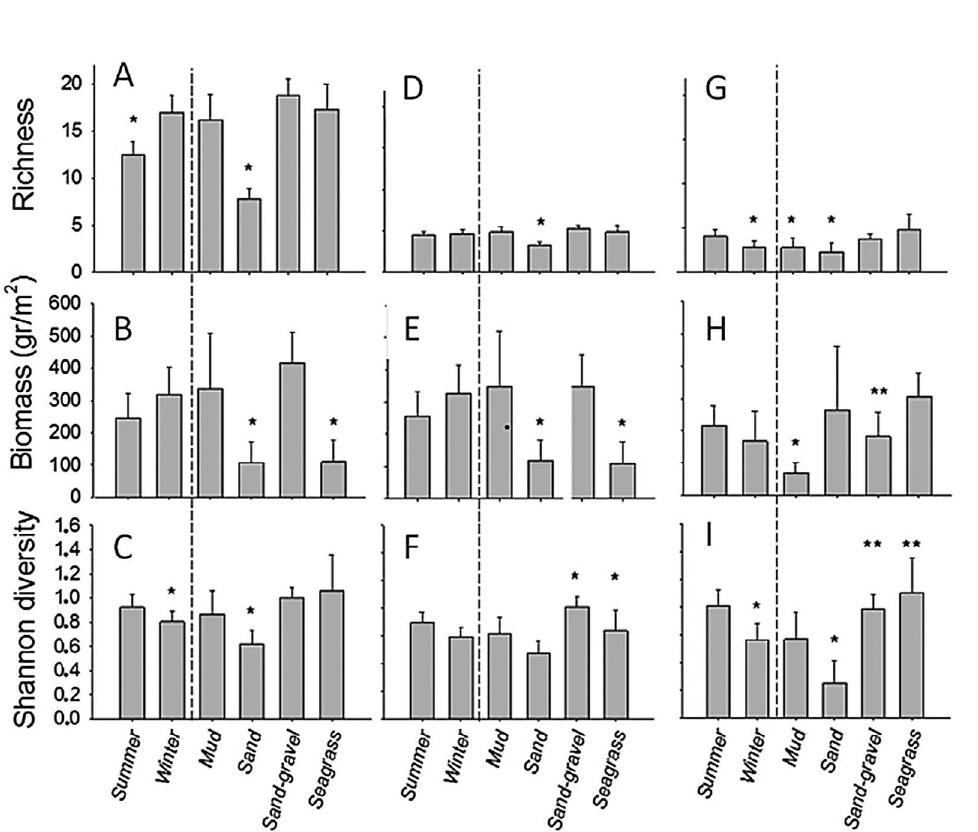
Fig. 2. – Invertebrate community richness, biomass and Shannon diversity (H’) variability across seasons and habitats in Tongoy Bay. (A, B, C), index estimations calculated for groups of species based on trophic behaviour (D, E, F) and macroalgae (G, H, I) in Tongoy Bay. The statistical differences (p≤0.05) between seasons and habitats are indicated by